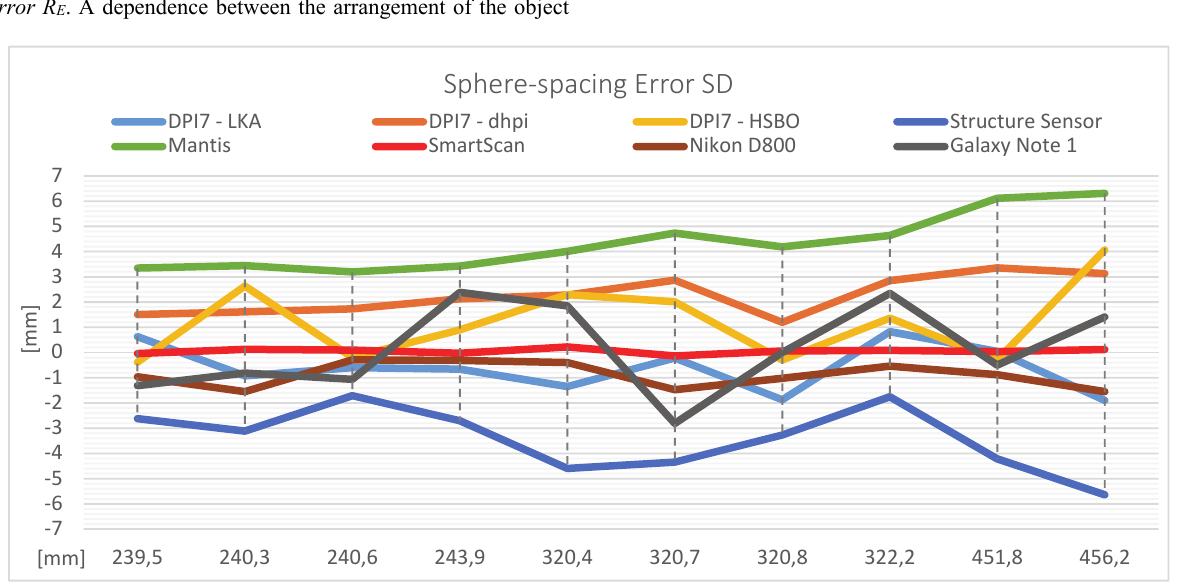
Figure 4. Quality parameter sphere-spacing error (SD) equivalent to VDI/VDE 2634, part 3